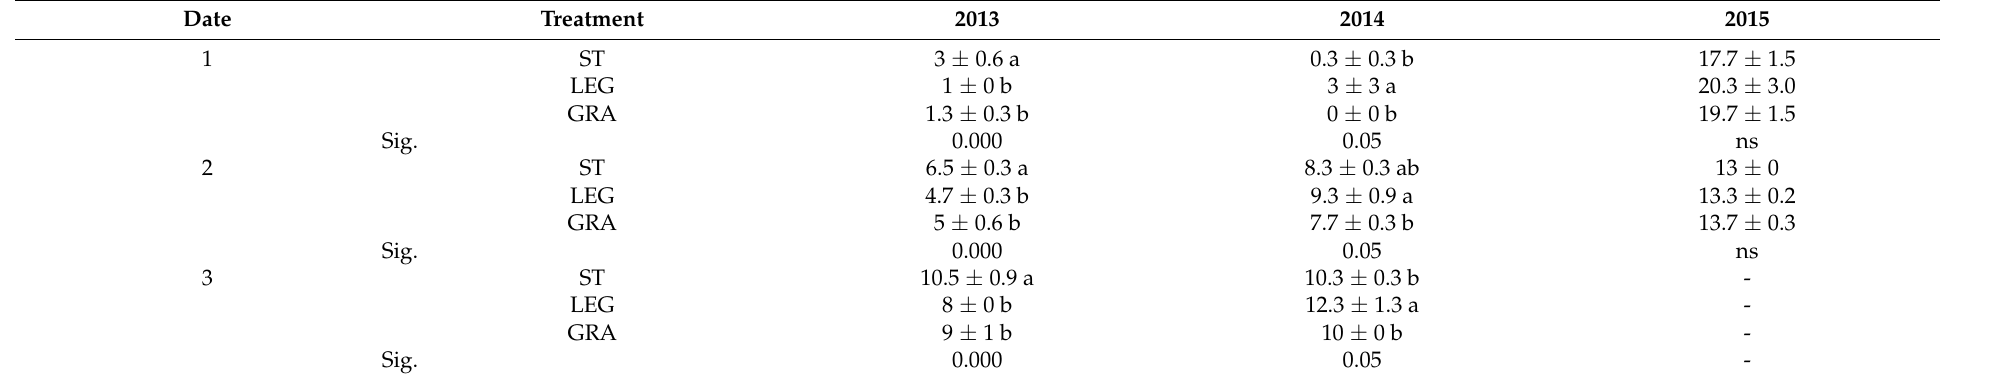
Table A3. Accumulated number of days with favorable microclimatic conditions (temperature, relative humidity, and humectation) for the development of P. viticola , from the beginning of the grapevine growing season until the first date of downy mildew monitoring on shoots (date 1) and from date 1 to dates 2 and 3. Values are the mean ± standard error and different letters in each column indicate significant differences among treatments at p -values < 0.05, ns—not significant.